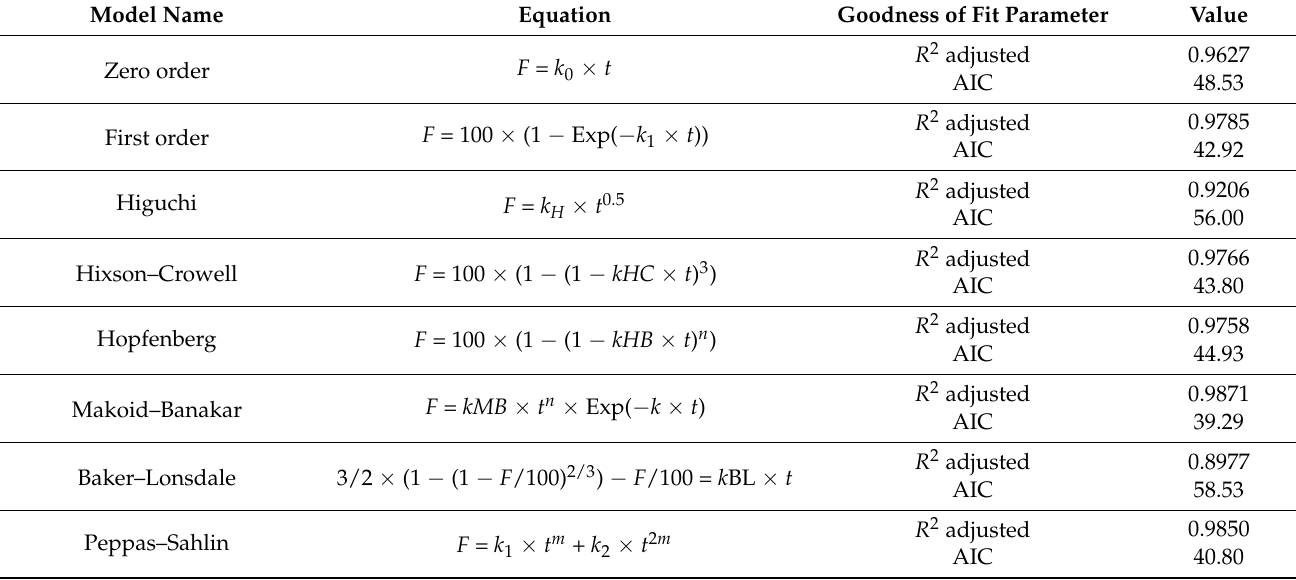
Table A1. Release parameters of fitted experimental data for in vitro permeation of dexamethasone through porcine vaginal mucosa. The best fit model will have a closest coefficient value to 1.0 ( R 2 adjusted) and a lower magnitude of data (AIC). Highlighted is the model that was deemed the best fit for the